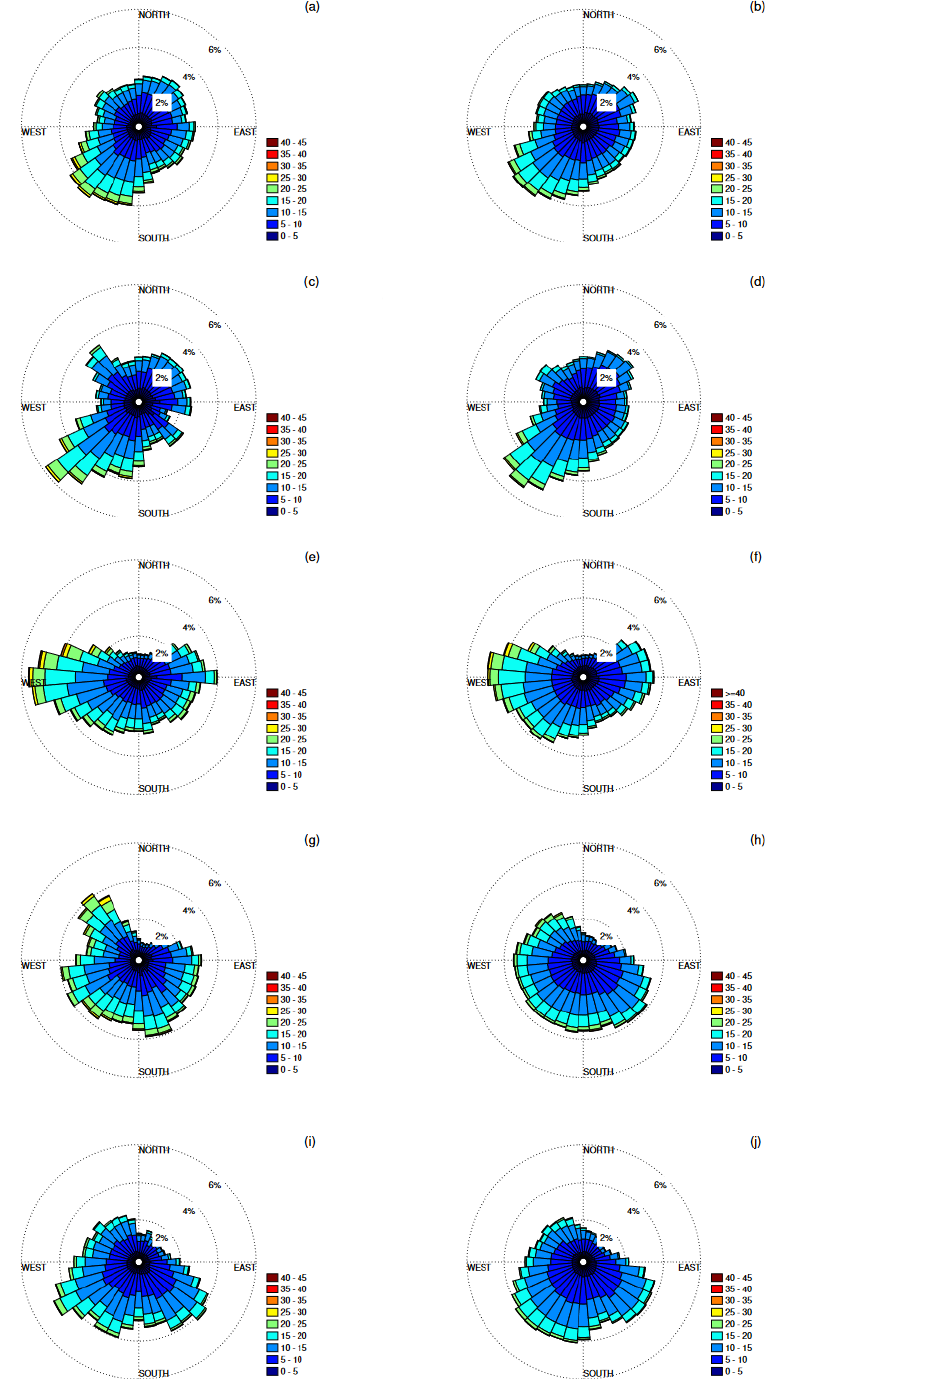
Figure A1. Observed (a, c, g, e, i) and modeled (b, d, f, h, j) wind roses for the five oil and gas platforms. The colors show the wind speed intervals in meters per second. (a, b) Heidrun; (c, d) Draugen; (e, f) Gullfaks C; (g, h) Sleipner; (i, j) Ekofisk.